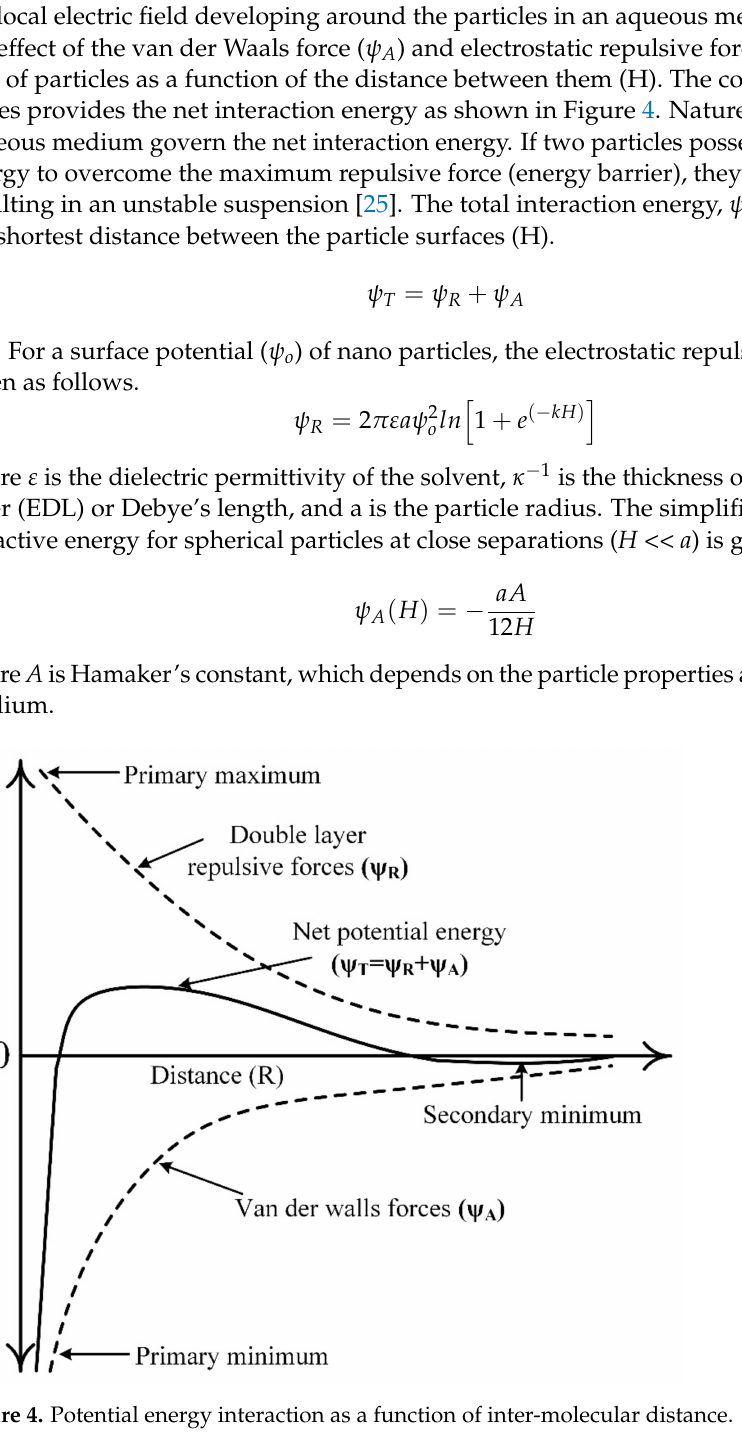
which is given below